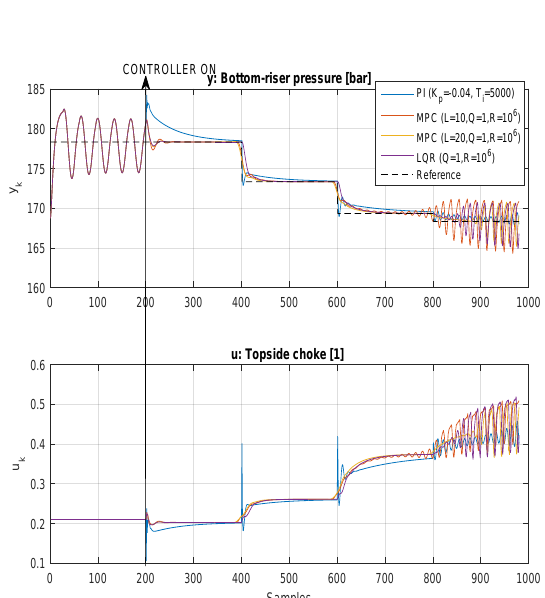
Figure 6: The subfigure above illustrates how the MPC converges to the LQR when the prediction horizon, L increases. The subfigure below il- lustrates the controller performances. MPC (L=20) and the LQR based @0.15 are able to stabilize the slugging regime up to choke opening 0.37 (zoomed in on the first and last part of Fig. 5.)